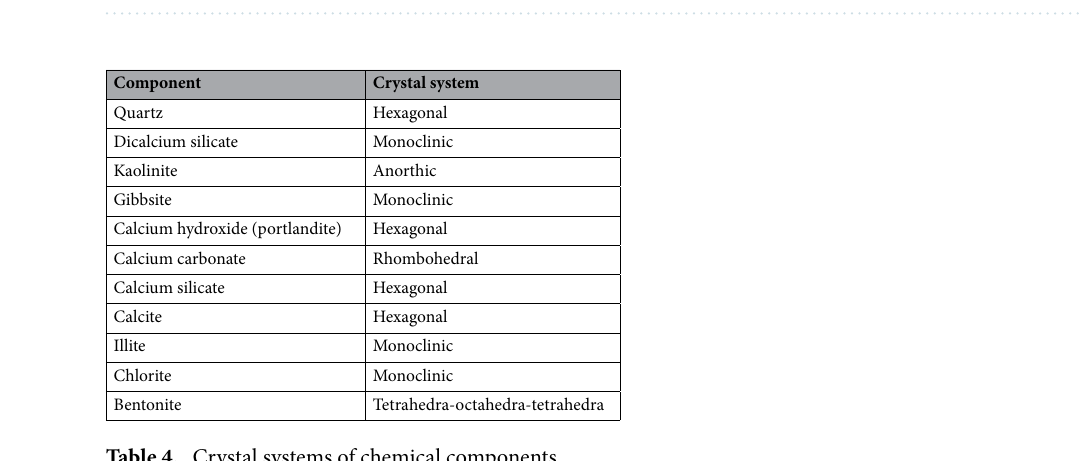
Figure 12. FTIR spectrum of K10, B10, and I10 samples.